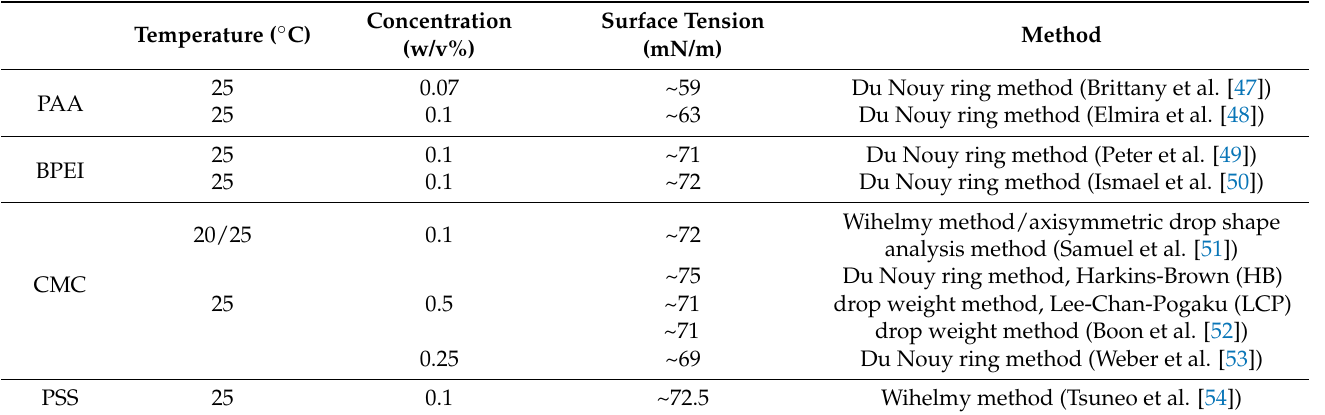
Table 1. Surface tension of PE solutions reported in the